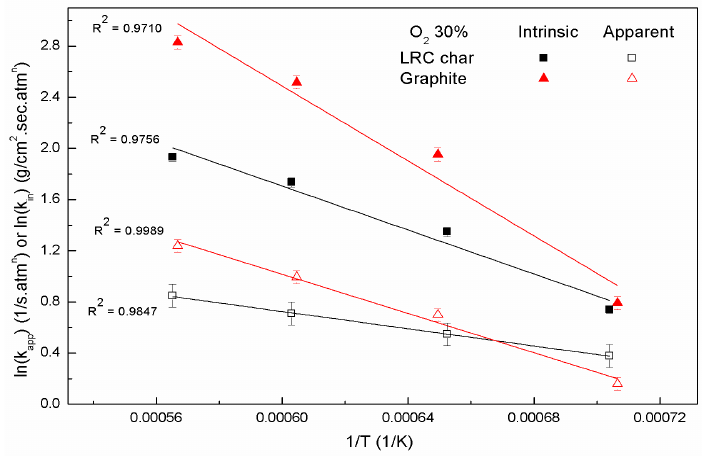
Figure 7. Comparison of reaction rate constants when considering oxygen diffusion at an ambient oxygen concentration of 30%.